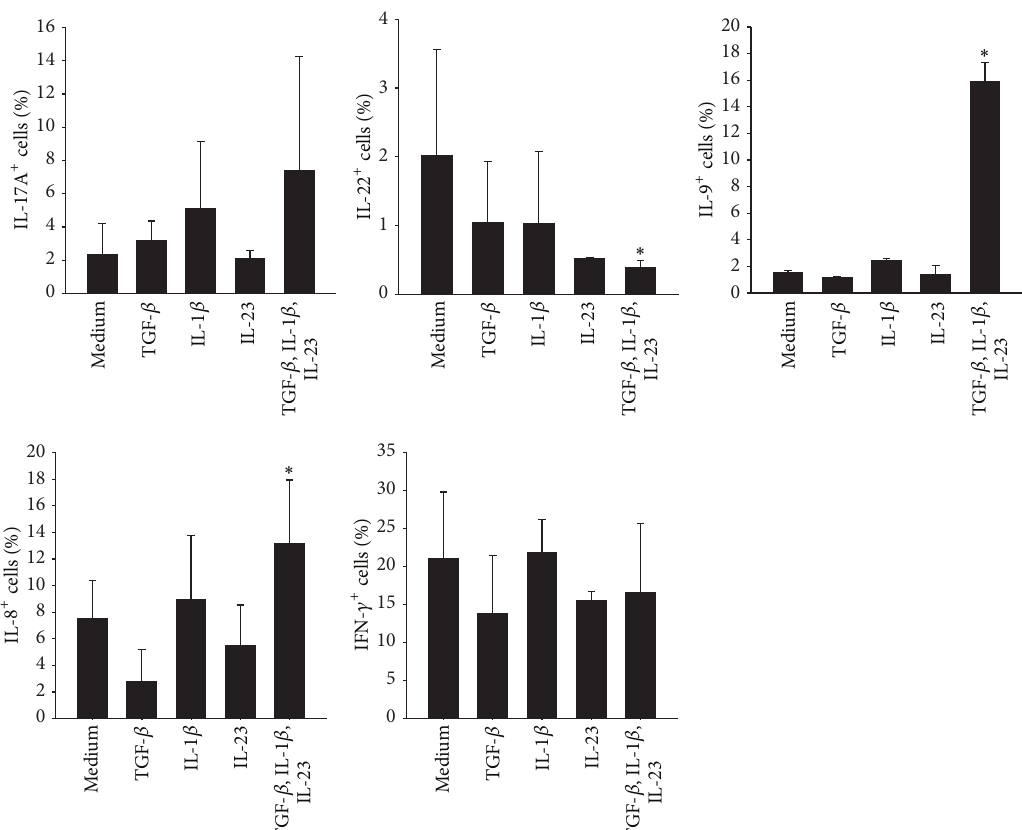
Figure 2: Effect of single cytokine application on the T helper cell cytokine production. Human CD4 + T cells were cultured with anti- CD3/anti-CD28 in the presence or absence of the indicated cytokines for 5 days. CD4 + T cells cultured with anti-CD3 and anti-CD28 were used as control (medium). After restimulation with PMA, Ionomycin, and Monensin for five hours and fixation/permeabilization the cells were stained for IL-17A, IL-22, IL-9, IL-8, and IFN- 𝛾 and analyzed by flow cytometry. The amount of cytokine producing cells [%] is represented as mean and SEM, ∗ represents significance compared to control, 𝑃 < 0.05 , Mann-Whitney 𝑈 test, and 𝑛 = 3